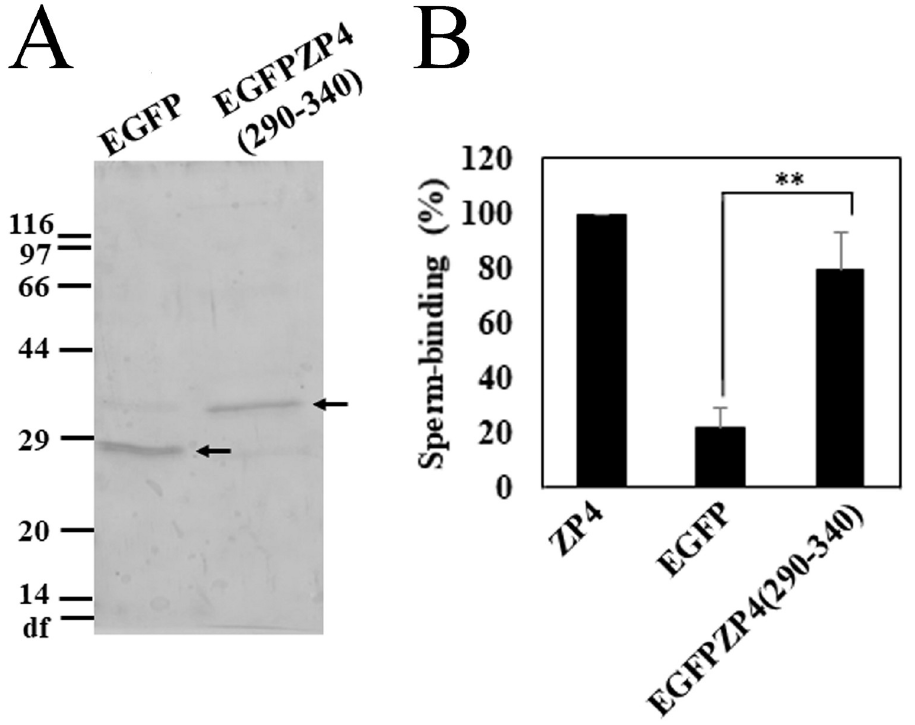
Fig 6. Sperm-binding activity of the region from Ser-290 to Lys-340 of bovine ZP4. (A) SDS-PAGE of enhanced green fluorescent protein (EGFP) and the fragment from Ser-290 to Lys-340 of bovine ZP4 fused to EGFP (EGFPZP4 (290–340)). These proteins were expressed in Sf9 cells and partially purified by using TALON resin specific to His-tag. Gels were silver-stained. The objective bands are indicated by arrows. Molecular mass standards (kDa) are indicated on the left side of the gel. df, dye front. (B) Sperm-binding activity of EGFP and EGFPZP4 (290–340). Plastic wells were coated with the recombinant proteins (1.0 μ g for each protein) indicated in the graph. The number of sperm bound to wells coated with ZP4 varied from 32 to 64 among experiments but was designated as 100% at each experiment. Assays were repeated five times. Data are presented as the mean ± SD, with statistical significance between EGFP and EGFPZP4 (290–340) indicated as P < 0.01 ( �� ) above the line.